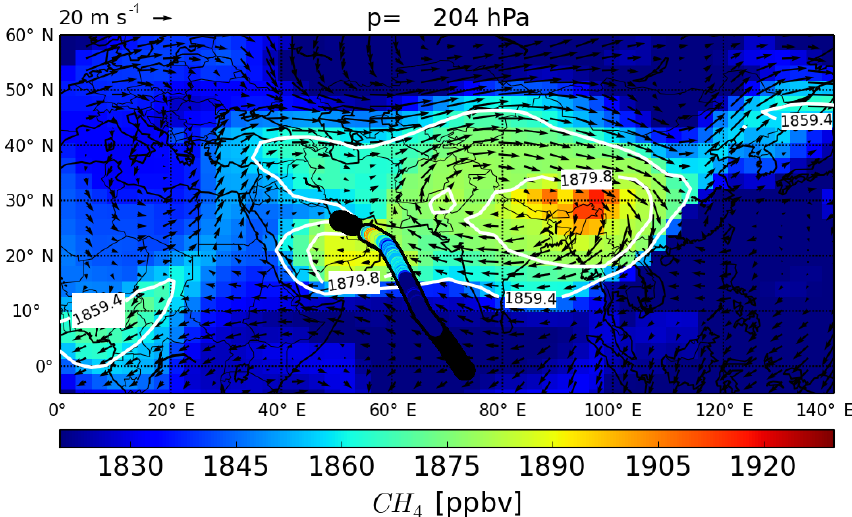
Figure 20. EMAC calculated CH 4 and wind field; daily means at 204hPa, and in situ CH 4 (above 300hPa) along the aircraft track for flight 12/13 (6 August 2015). White contours represent the CH 4 threshold and background values according to Sect. 3.1. The enhanced CH 4 values over Oman represent the outflow.